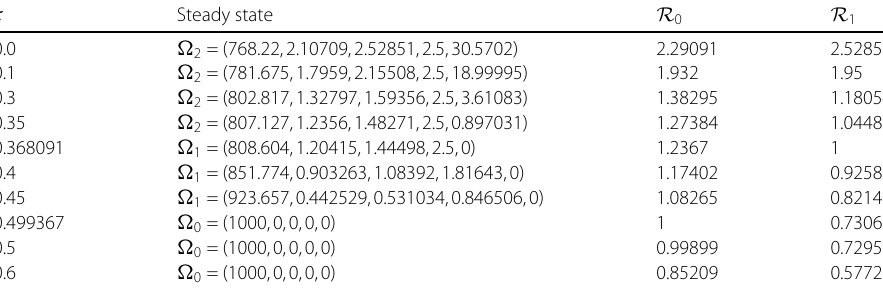
Table 2 The values of R 0 and R 1 for system (2) with different values of τ τ Steady state R 0 R 1